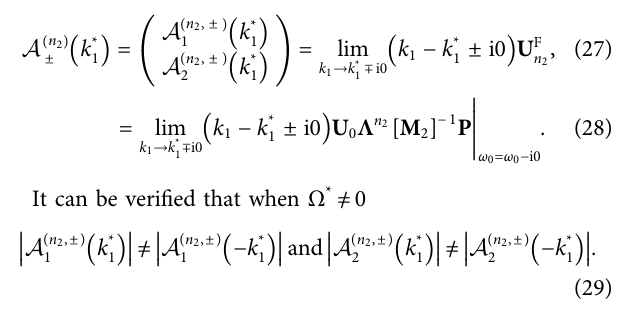
Frontiers in Materials |